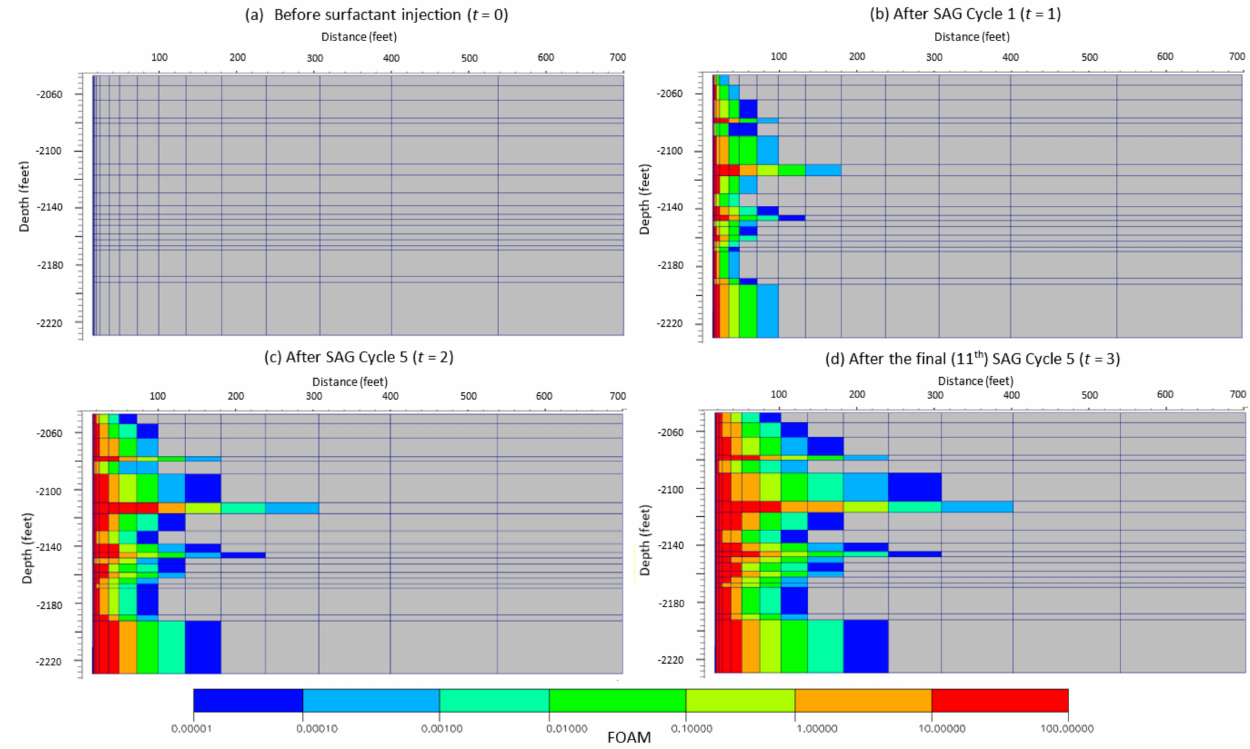
Figure 12. Foam concentration in a 2D slice ( r − z ) of the radial simulation model from ( a ) before surfactant injection, ( b ) after the 1st surfactant-alternating-gas (SAG) cycle, ( c ) after the 5th SAG cycle, and ( d ) after the 11th (final) SAG cycle. Injection was from left to right in each